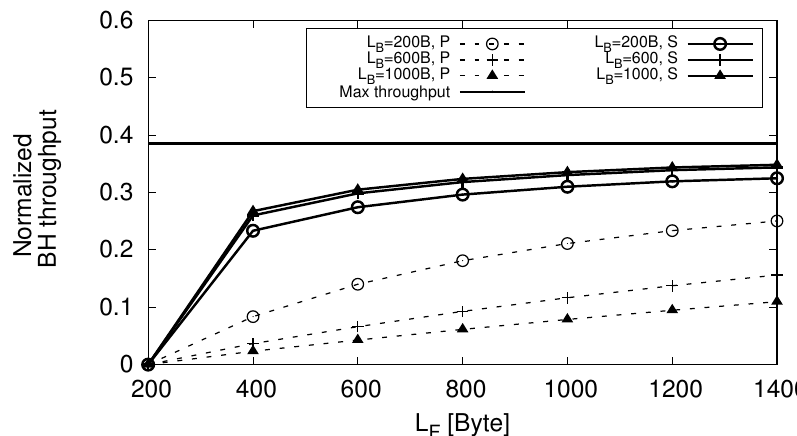
Figure 7. Backhaul (BH) throughput, normalized to the output link capacity, as a function of payload length L F for different BH packet length L B using CPRI opt. 6. Solid lines for the case with segmentation (S), dashed lines for the no-segmentation case (P). Maximum normalized capacity by fronthaul (FH) is shown by a solid line.